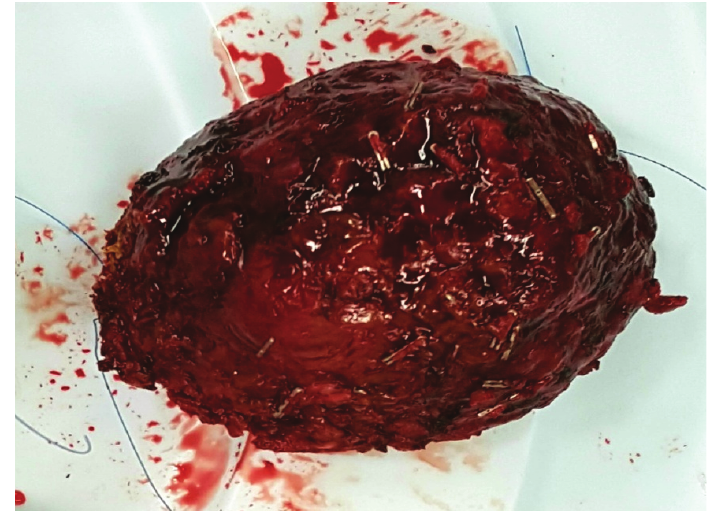
Figure 5: Postoperative circular hepatic tissue contained HCC mass.